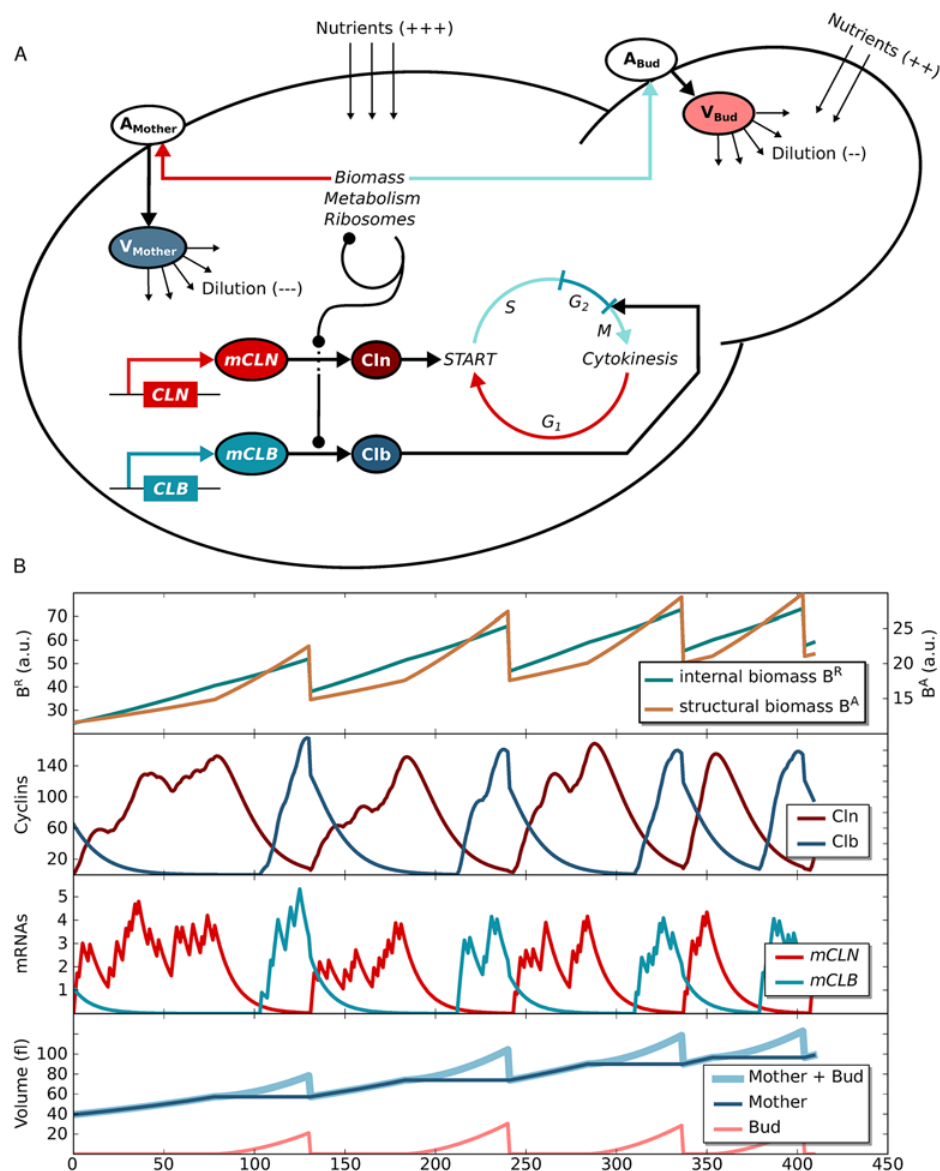
Fig 1. Schematic growth model and its dynamics. (A) The model produces internal biomass (ribosomes, metabolic enzymes, polymerases etc.) in a self-replicating fashion. It also accumulates structural biomass that forms the cell area (membrane and wall). Depending on cell cycle stage the area of the mother (G 1 ) or the bud (S-G 2 -M) grows. Biomass dependent translation of cyclins triggers cell cycle transitions (Cln: G 1 /S; Clb: G 2 /M; S and M phases are constant). There are two model versions to distinguish translation of mCLB in the whole cell (Model-1) or only in the bud (Model-2). (B) Trajectories of Model-1 variables for one realization of four consecutive cell cycles starting with a new-born cell, then following the mother line. Cyclins and mRNAs are given in molecule numbers.